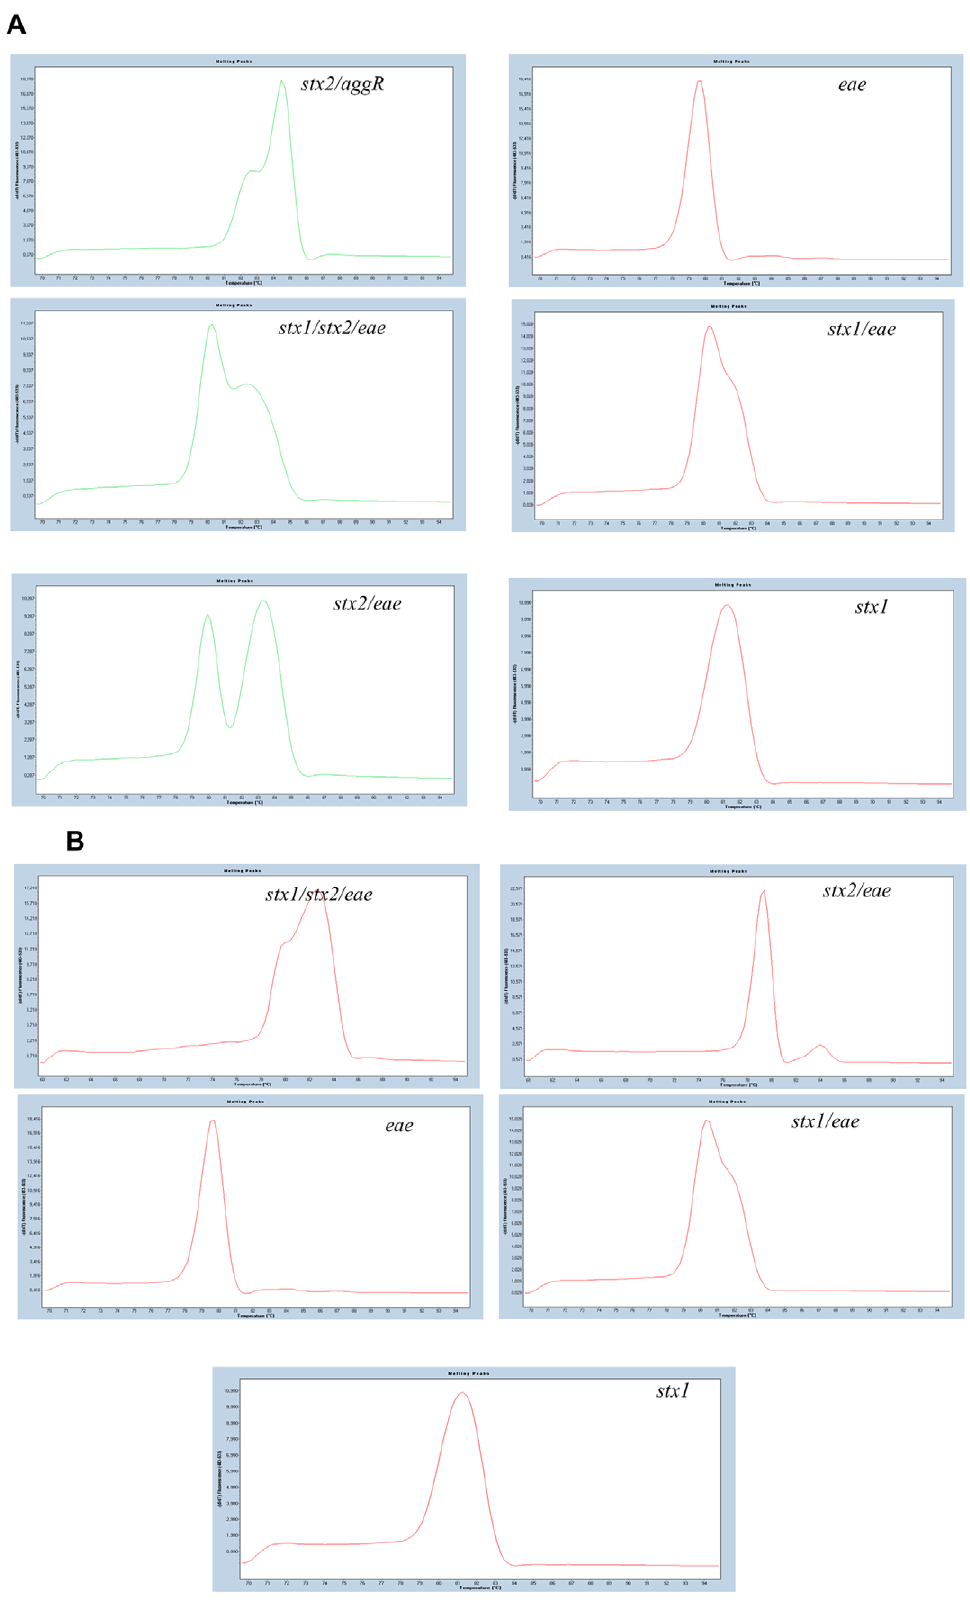
Figure 2. Melting peaks of amplicons in (A) triplex and (B) duplex PCR. Respective targets are indicated on each graph.